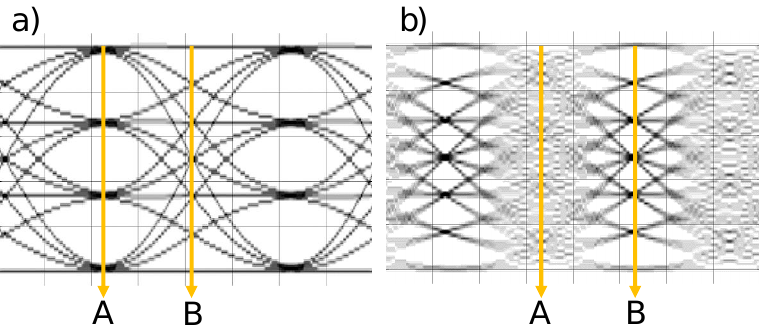
Figure 1. Eye diagrams of PAM-4 signal under light ( a ) and strong ( b ) filtering effect. A and B represent the sampling points used to retrieve the PAM-4 and the 7-level DB-PAM-4 signals,